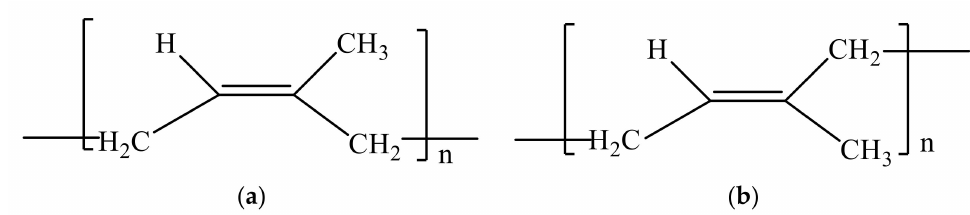
Figure 1. Macromolecular structures of NR and EUG. ( a ) The chemical structure of NR; ( b ) the chemical structure of